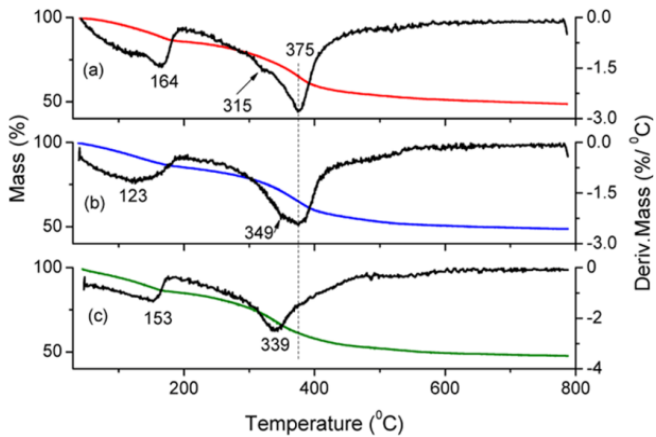
Figure 3. TGA-DTG curves of LDHs, ( a ) LDH-Ni; ( b ) LDH-Co; ( c ) LDH-Cu.